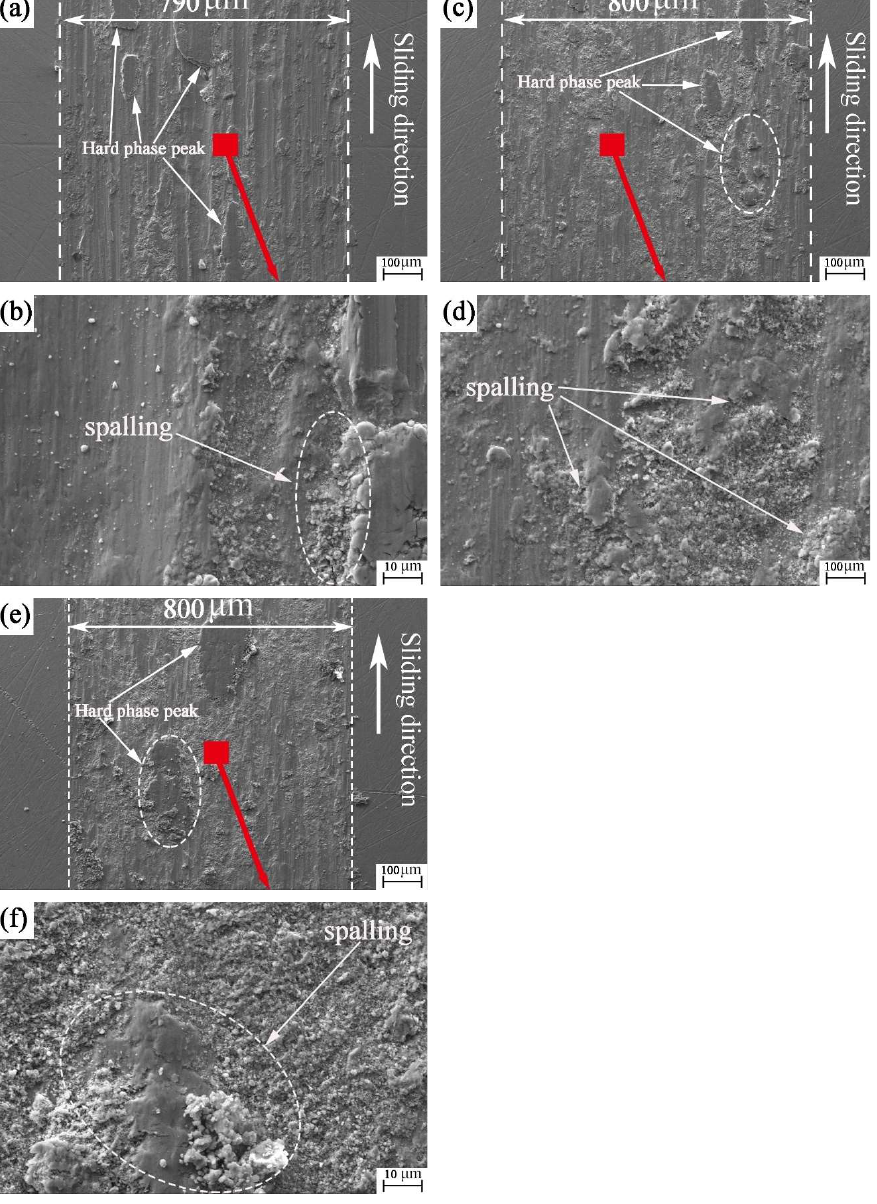
Figure 9. SEM images of the untextured worn plates: ( a , b ) rotation radius 15 mm; ( c , d ) rotation radius 18 mm; and ( e , f ) rotation radius 22.5 mm.